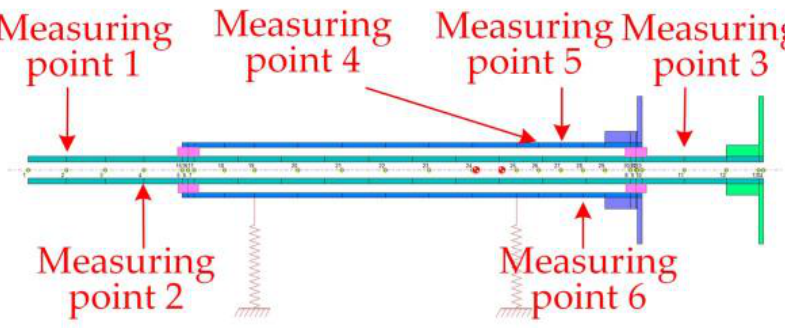
Figure 7. Measuring points of simulation.